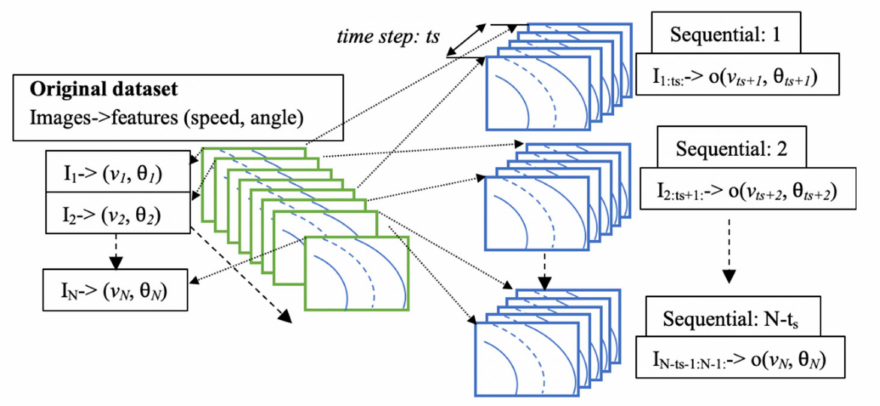
Figure 7. Composition of sequential images and output values